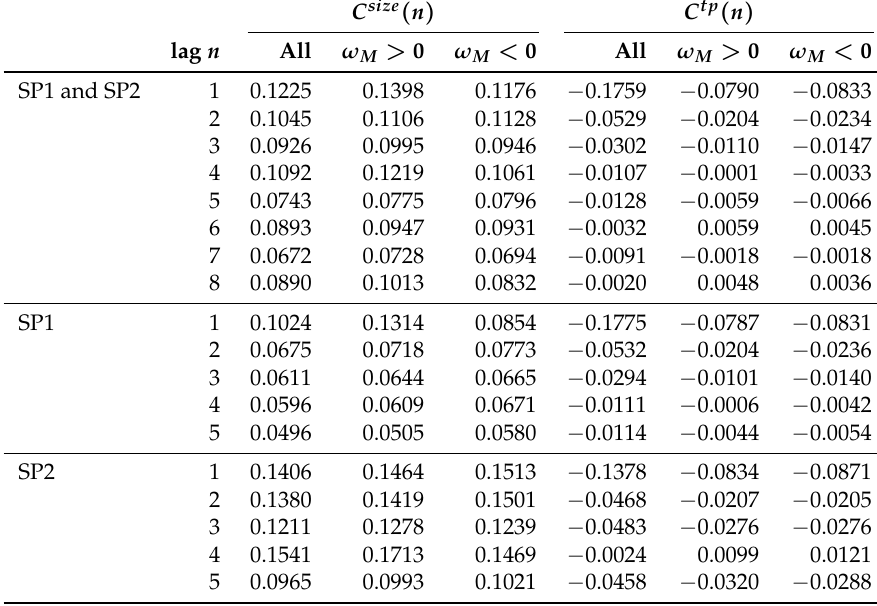
Table 10. Autocorrelation of trade properties. We compute the autocorrelation functions of trade price changes C tp ( n ) and trade sizes C size ( n ) for lags n = 1, . . . ,10. We show results for all trades, for ask-initiated trades ( ω M > 0) and bid-initiated trades ( ω M < 0)